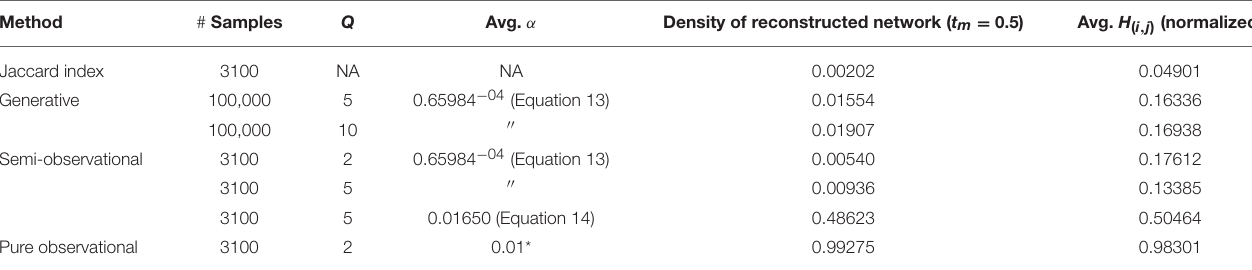
TABLE 1 | Collection of fundamental model and network parameters, for a set of network reconstruction methods, and basic metrics resulting from the analysis. Method